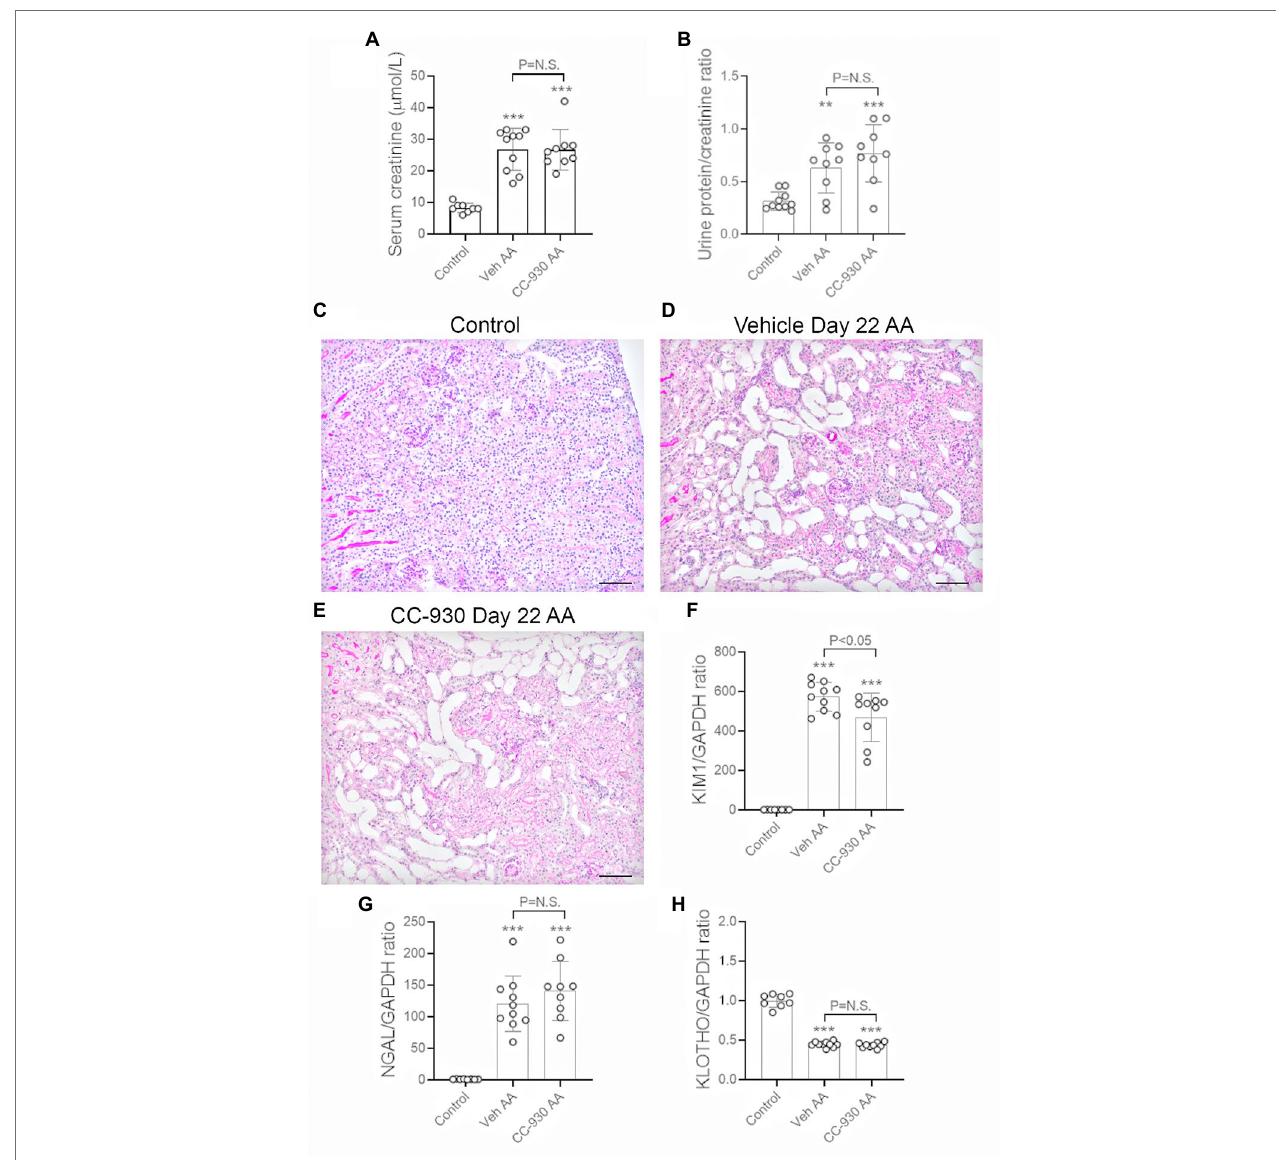
FIGURE 5 | Renal function and tubular damage on day 22 of aristolochic acid (AA) induced chronic kidney disease. Vehicle and CC-930 treated AA groups were compared to normal controls. (A) Serum creatinine levels. (B) Urinary protein excretion measured as a ratio of mg total protein/mol creatinine. (C) PAS staining of normal control kidney. (D) PAS staining of vehicle treated AA shows marked tubular atrophy, interstitial cell infiltration and occasional tubular casts, while glomeruli are largely normal. (E) PAS staining of CC-930 treated AA shows similar chronic tubular damage to that in vehicle treated. Bars represent 100 μ m. RT-PCR analysis of: (F) KIM-1/HAVCR1, (G) , NGAL/LCN2, and (H) α -Klotho mRNA levels. One-way ANOVA with Tukey’s multiple comparison test. ** p < 0.01 and *** p < 0.001 vs. control. N.S., not